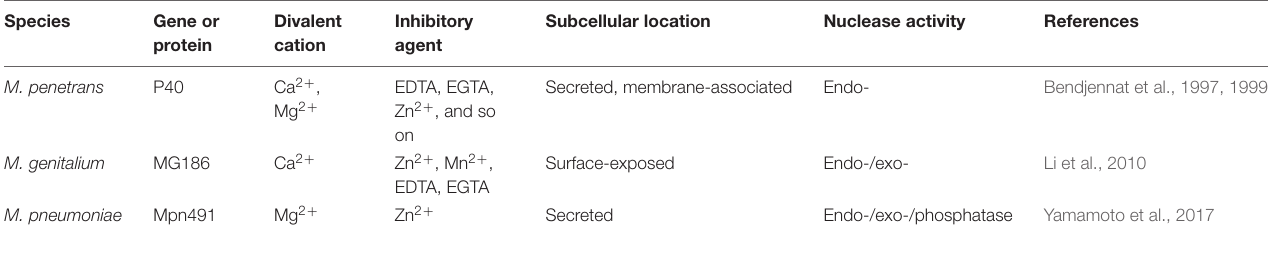
TABLE 1 | Nuclease characteristics in human pathogenic mycoplasmas.